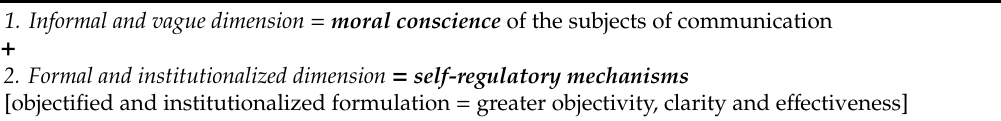
Table 1. Dimensions of social communication